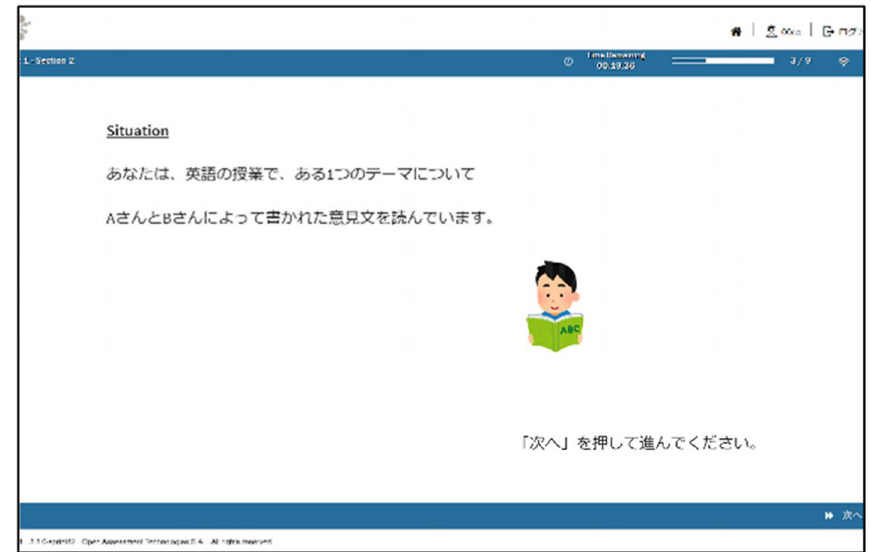
Fig. 2 Screen 1: Understanding the scene and situation